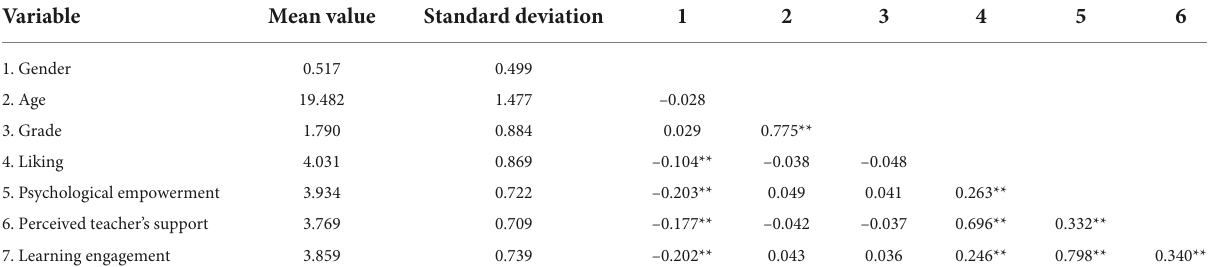
TABLE 2 Mean value, standard deviation, and correlation coefficient of variable ( N = 1,279).